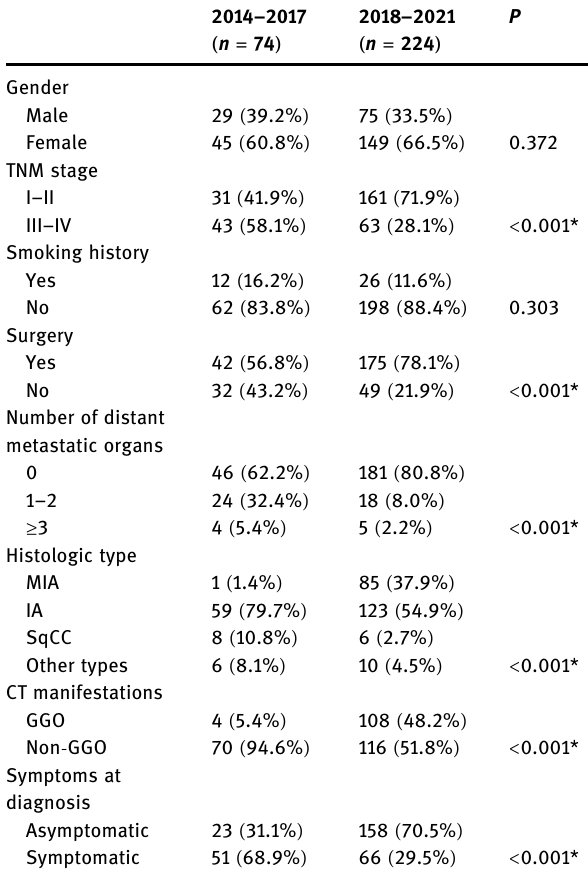
Table 3: Comparison of clinicopathological fi ndings of the young patients with NSCLC between 2014 – 2017 and 2018 –